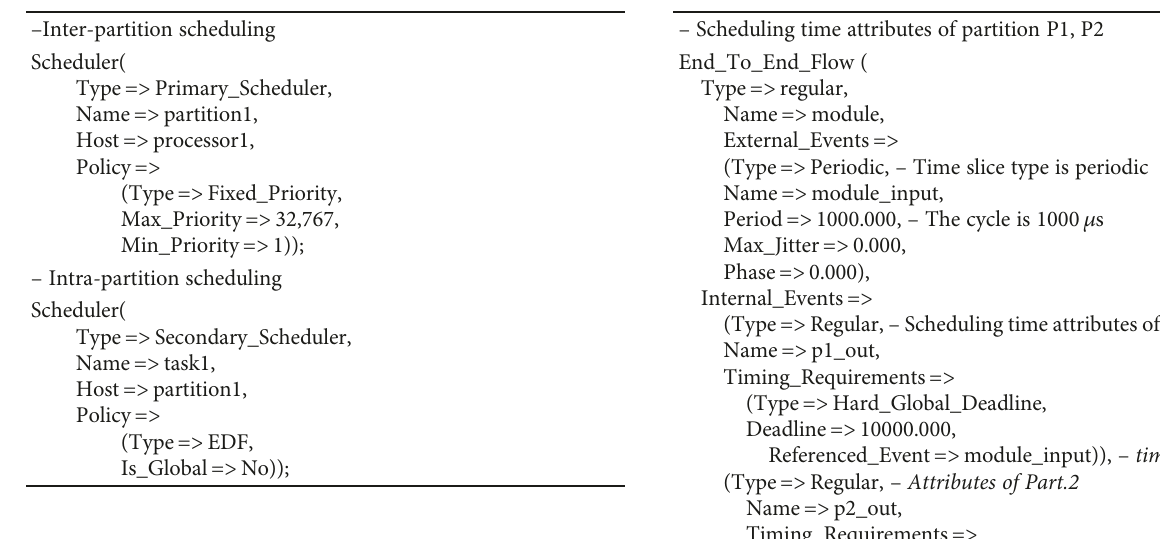
Table 8: Scheduler model element description.